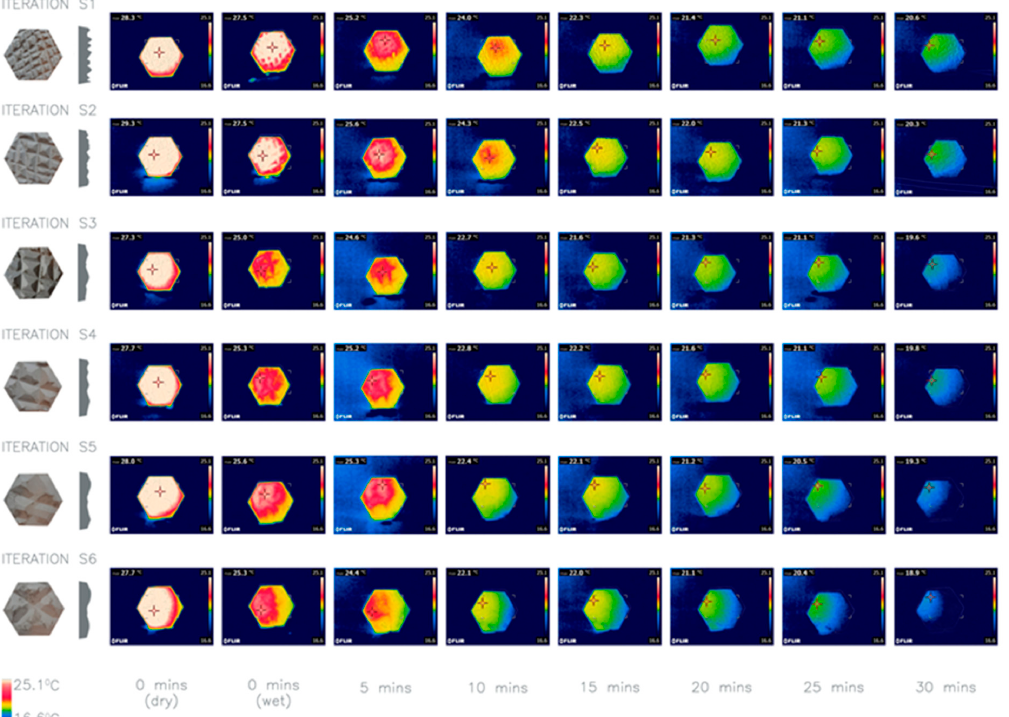
Figure 7. Thermal imaging of investigation 4: comparison of six iterations S1–6 with different texture scales. Surface area to volume ratios: S1 1.36, S2 1.24, S3 1.19, S4 1.17, S5 1.16, and S6 1.14. Average heat loss after 30 min: S1 8.96 °C, S2 9.8 °C, S3 7.66 °C, S4 9.13 °C, S5 8.8 °C, S6 9.43 °C.